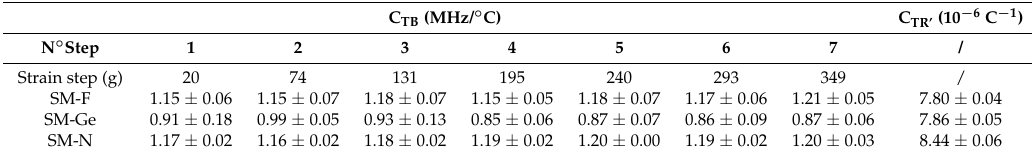
Figure 12. Brillouin Temperature coefficient C TB evolution as a function of strain step for the F-doped, Ge-doped and N-doped fibers, after an irradiation dose of 56 kGy. The solid line in the middle indicates the average values while the dotted lines highlight a maximum variation of 1.1%. As a reference, green points are for pristine samples. Table 3. Temperature coefficients extracted from Brillouin and Rayleigh measurements and relative errors after irradiation at TID of 56 kGy.